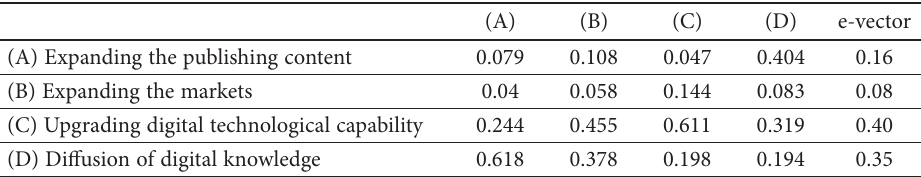
Table 2. The pair-wise comparison of